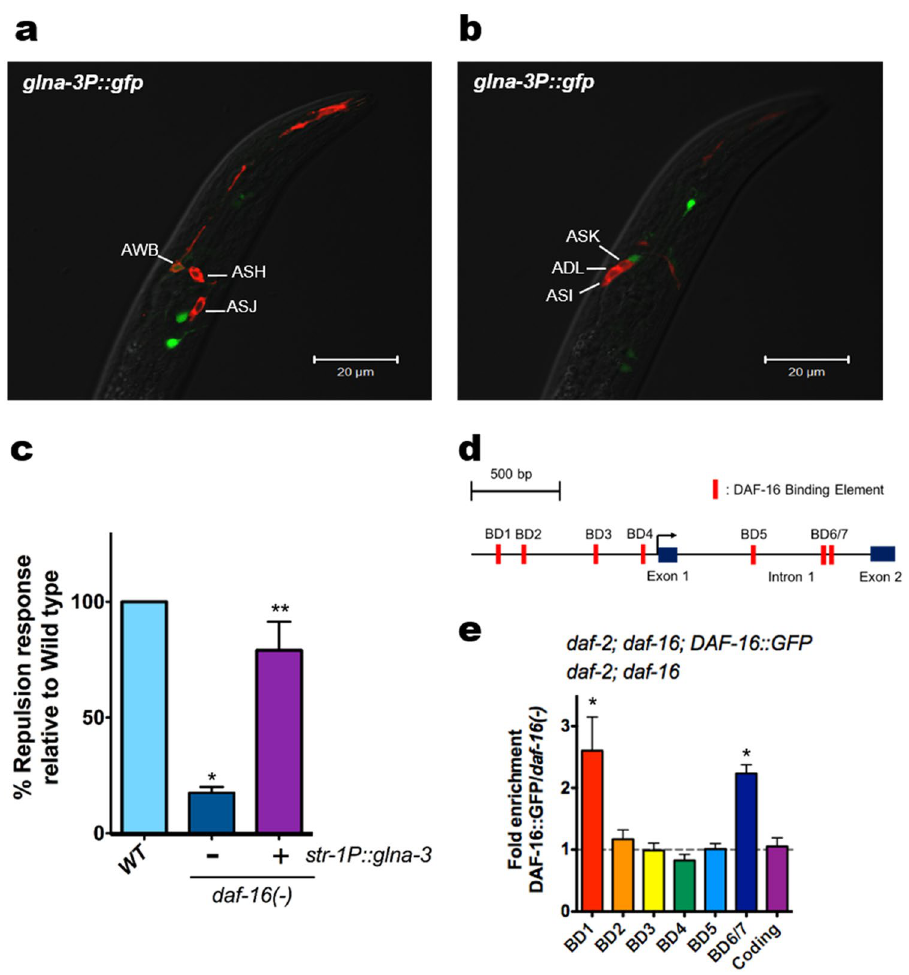
Figure 3. Expression pattern of glna-3P:gfp and ChIP analysis of DAF-16/FoxO::GFP bound to the upstream region of glna-3 gene (a) and (b) Expression pattern of glna-3P::gfp . Worms were also stained with DiI dye to visualize chemosensory amphid neurons. (c) str-1P::glna-3 rescued daf-16/FoxO mutant phenotype (wild type, n = 160; daf-16/FoxO , n = 155; str-1P::glna-3; daf-16/FoxO , n = 150.) * P < 0.05 compared to wild type, ** P < 0.05 compared to daf-16/FoxO . (d) Putative DAF-16/FoxO binding sites in the 5 ′ upstream region and first intron of the glna-3 gene . (e) ChIP of DAF-16/FoxO::GFP with anti-GFP antibody in daf-2;DAF-16/FoxO and daf- 2;DAF-16/FoxO;DAF-16/FoxO::gfp mutants. Bars represent the mean of three independent biological replicates. * P < 0.05 compared to daf-2;DAF-16/FoxO . Significance was determined using two-tailed, unpaired t